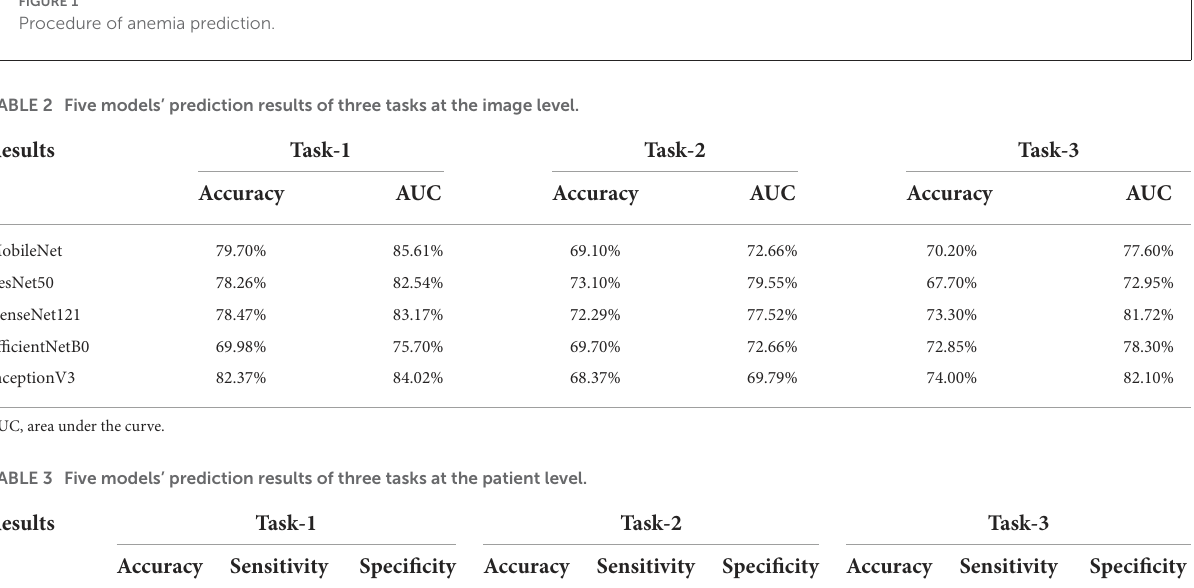
FIGURE1 Procedure of anemia prediction.